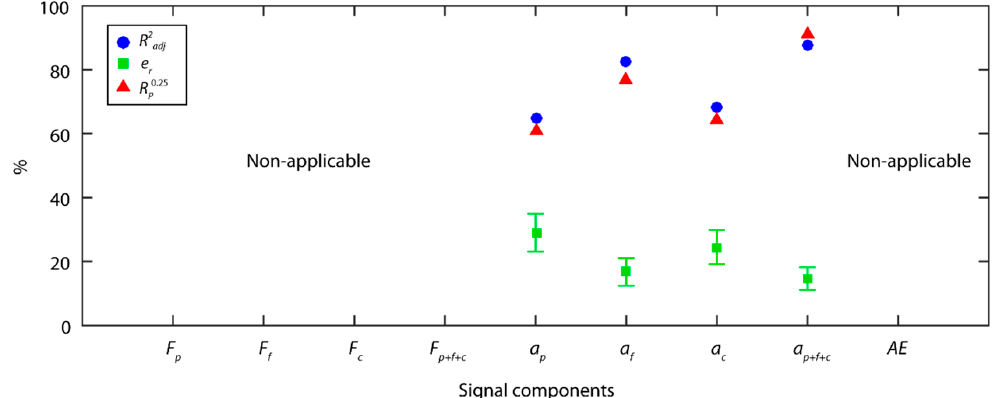
Figure 11. Signal analysis results with the SSA method.